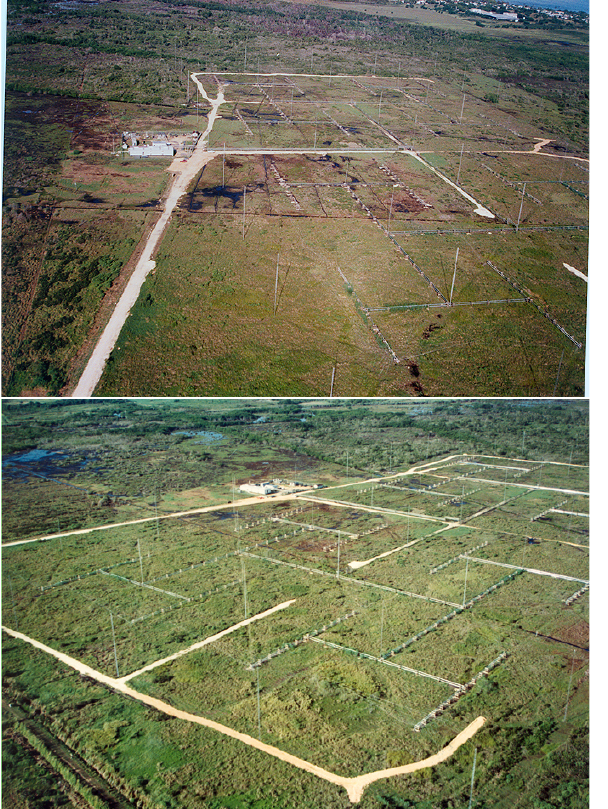
Figure 7. The Islote heater facility circa 1997. In these aerial views most of the two 4 × 4 log periodic antenna arrays is visible with the transmitter / control building to the left / top and the ocean just visible at the top right. The dual, closed coaxial “cable” (constructed from irrigation pipe) transmission line system to the center of each log periodic feed is clearly visible as are the support towers. The wire log periodic feeds are not visible but are suspended from four towers with two linear polarizations each driven from a separate transmission line. Photo courtesy of Cornell University and Arecibo